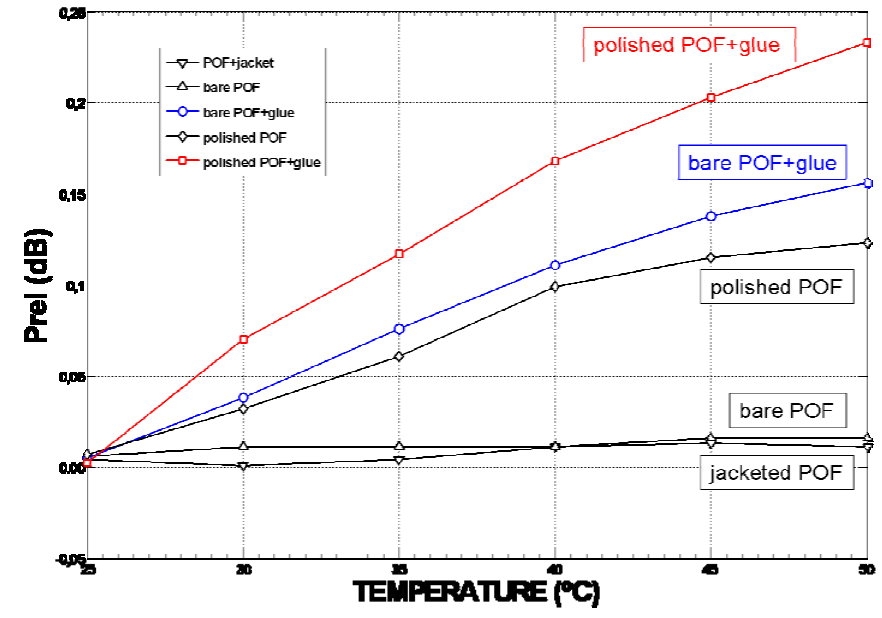
Figure 8. Temperature dependence for different fiber status from T = 25 ºC to T = 50